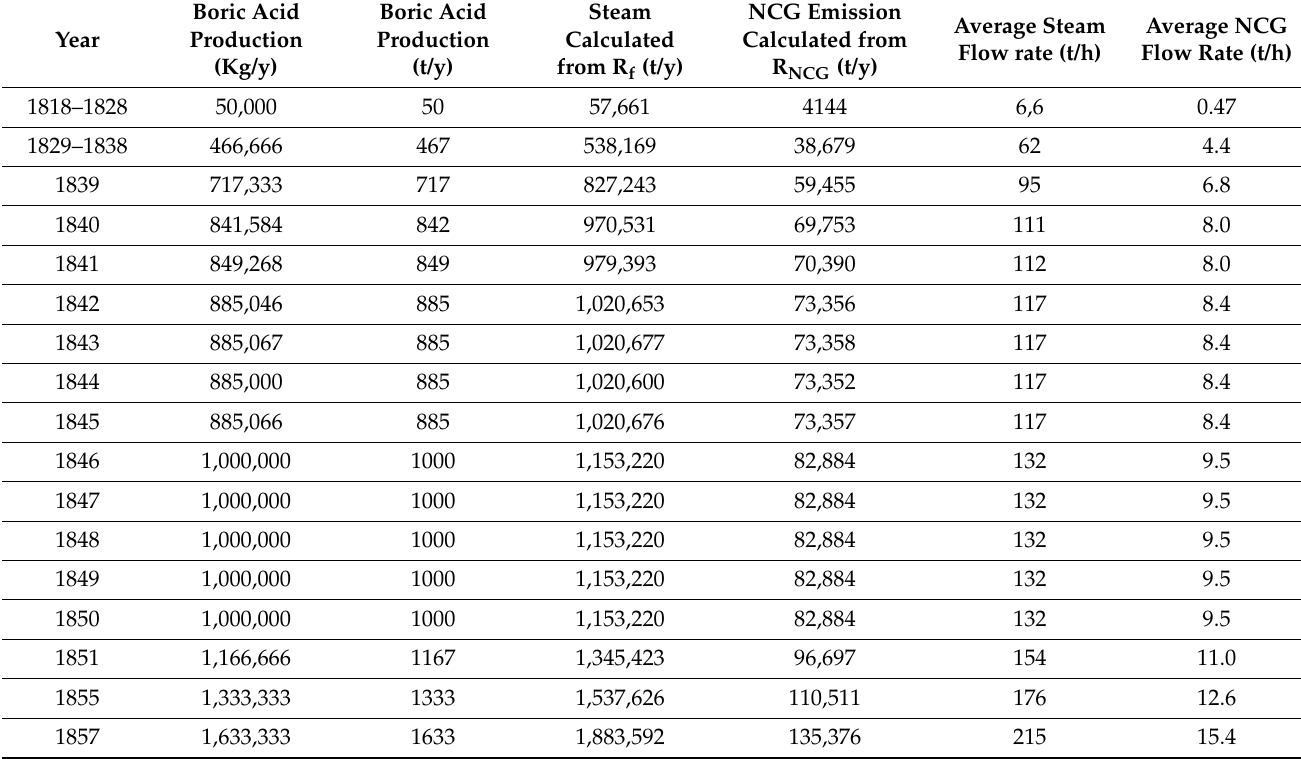
Table 3. Calculated steam flow rates and NCG flow rates from boric acid production data according to ref. [34].